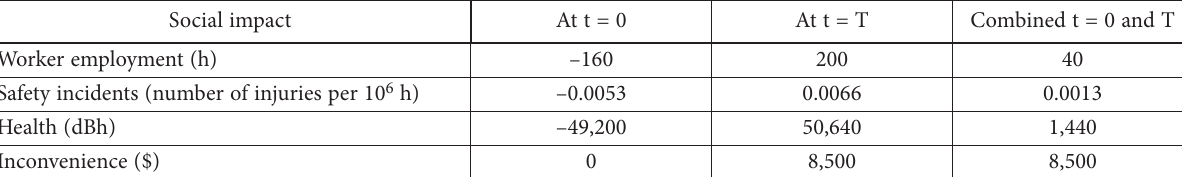
Table 5. Differences (NA - A) in social